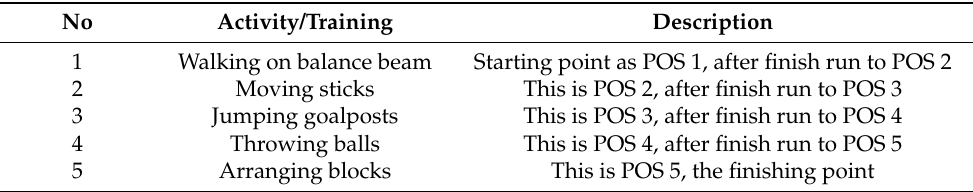
Table 1. The training